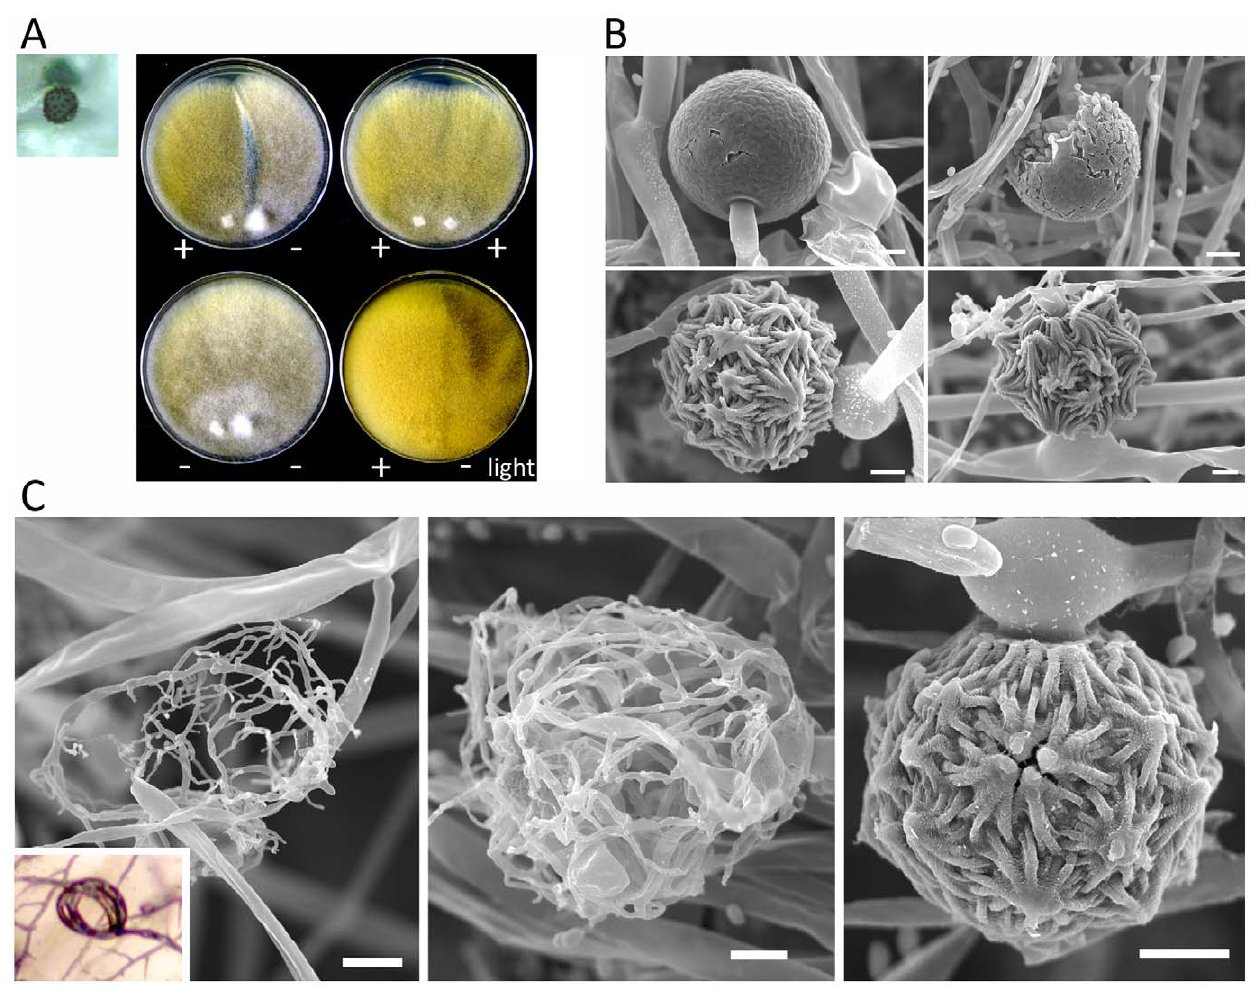
Figure 8. Sexual development of Mucorcircinelloides . Light and scanning electron microscopy images were obtained with mounted samples of zygospores and other mating structures. (A) Images show a zygospore (enlarged insert) as viewed by light microscopy and the dark zygospore line that forms during mating. ( + ) and ( 2 ) designations indicate mating types of strains (ATCC1216a ( 2 ) and ATCC1216b ( + ) Mcl strains). A distinct dark zygospore line was found in ( + )/( 2 ) co-cultures but not in same-sex mating pairs. All matings were performed for 7 days in the dark with the exception of the bottom right plate that was incubated in the light at room temperature. Mating occurred in the dark and not in the light. (B) The sporangium (upper panels), the asexual spore harboring structure, and zygospores (lower panels), the sexual spores, are shown at higher magnification by SEM. (C) The formation of the zygospore structure is depicted by SEM. Zygospore formation is initiated by the production of coiled hyphae that entangle to form the mature zygospore. Coiled hyphae in a mating between ATCC1207a and ATCC1207b are presented in the small rectangular area (light microscopic image). Scale=10 m m.